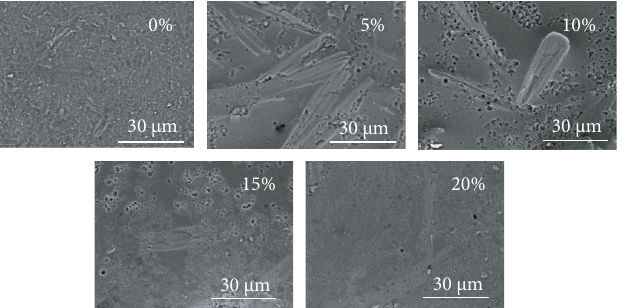
Figure 4: SEM micrograph of fractured surfaces of phosphor-in-glass ceramic aggregates with varying phosphor contents. The bar shows a 30 μ m scale. The samples were etched in HF solution for 30 s.